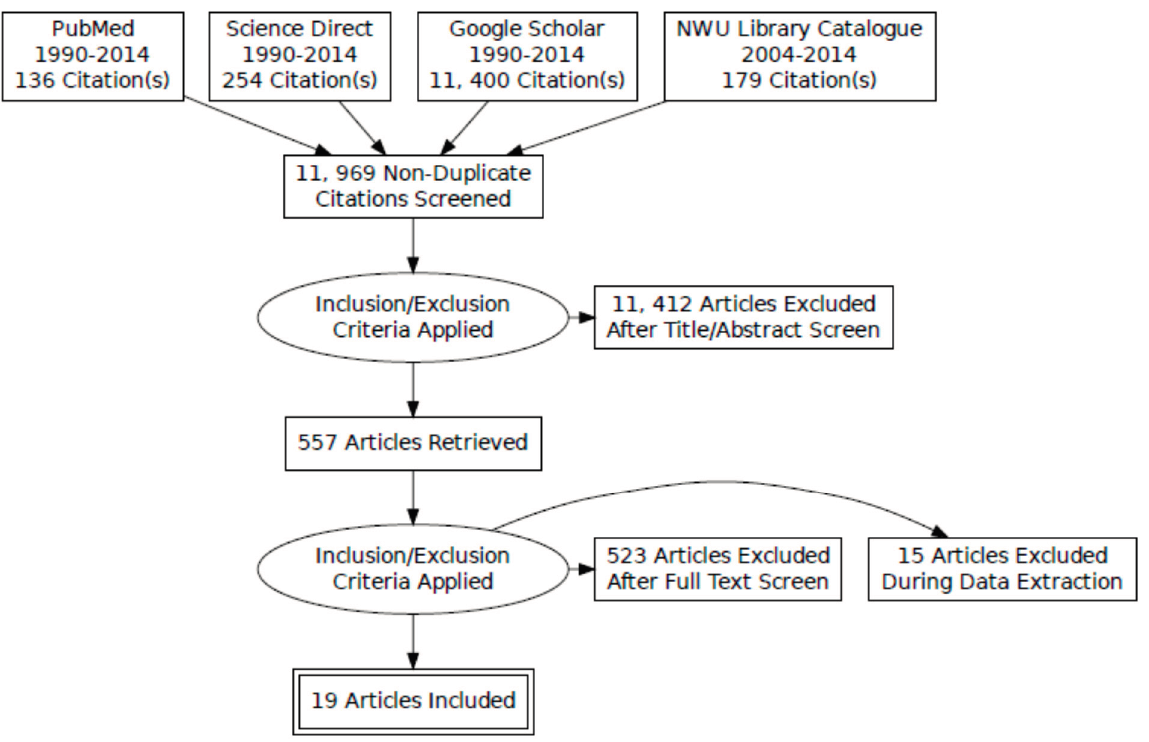
Figure 1. PRISMA flow chart of search strategy